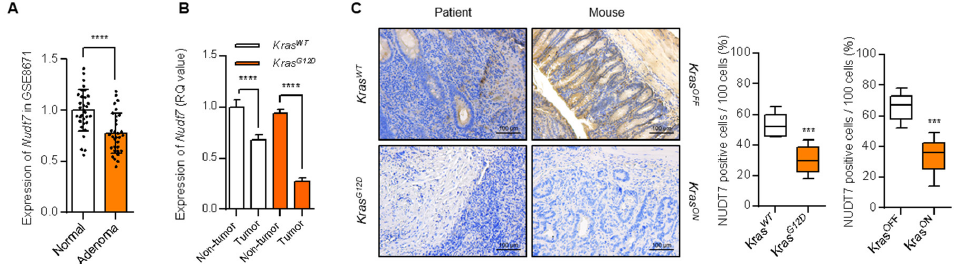
Figure 2. Decreased level of peroxisomal Nudt7 is observed in Kras G12D CRC dysregulation. ( A